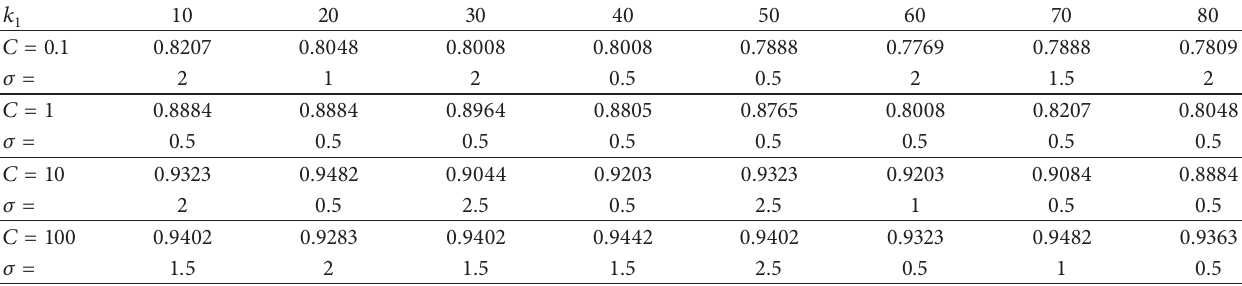
Table 1: The effects of parameter 𝐶 and sample neighborhood 𝑘 1 on classification performance.